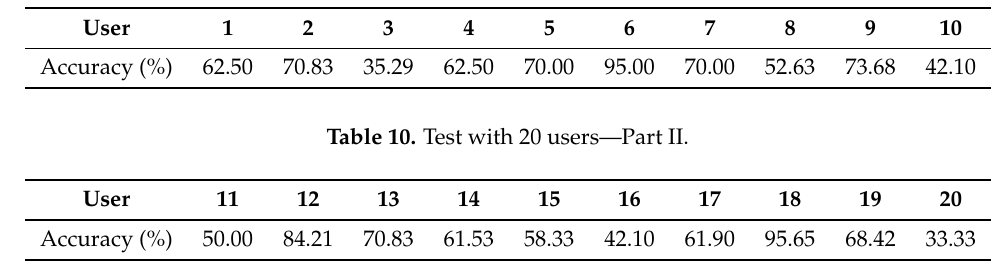
Table 9. Test with 20 users—Part I.